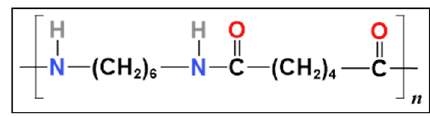
Figure 1: Molecular structure of nylon 66.